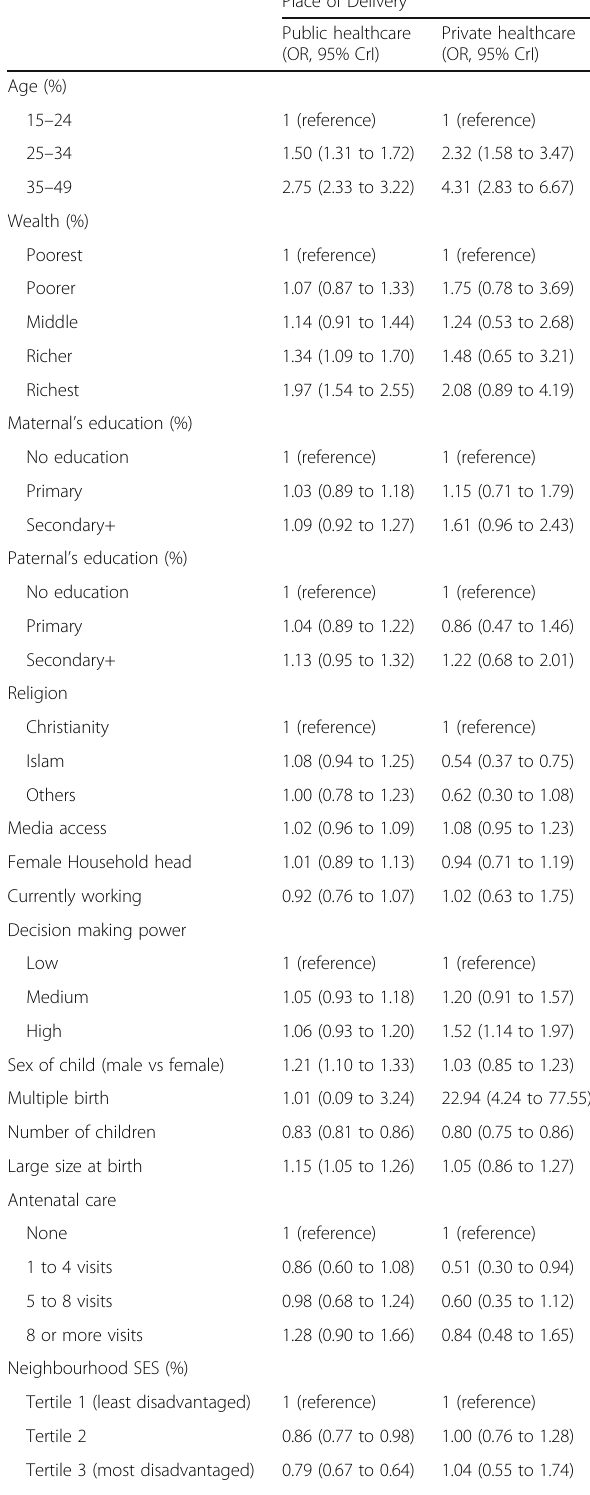
Table 3 Individual compositional and contextual factors associated with Caesarean section in sub-Saharan Africa identified by multivariable multilevel logistic regression models, Demographic and Health Surveys data